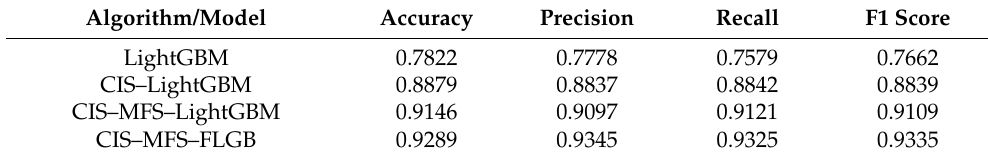
Table 2. Overall performance comparison.